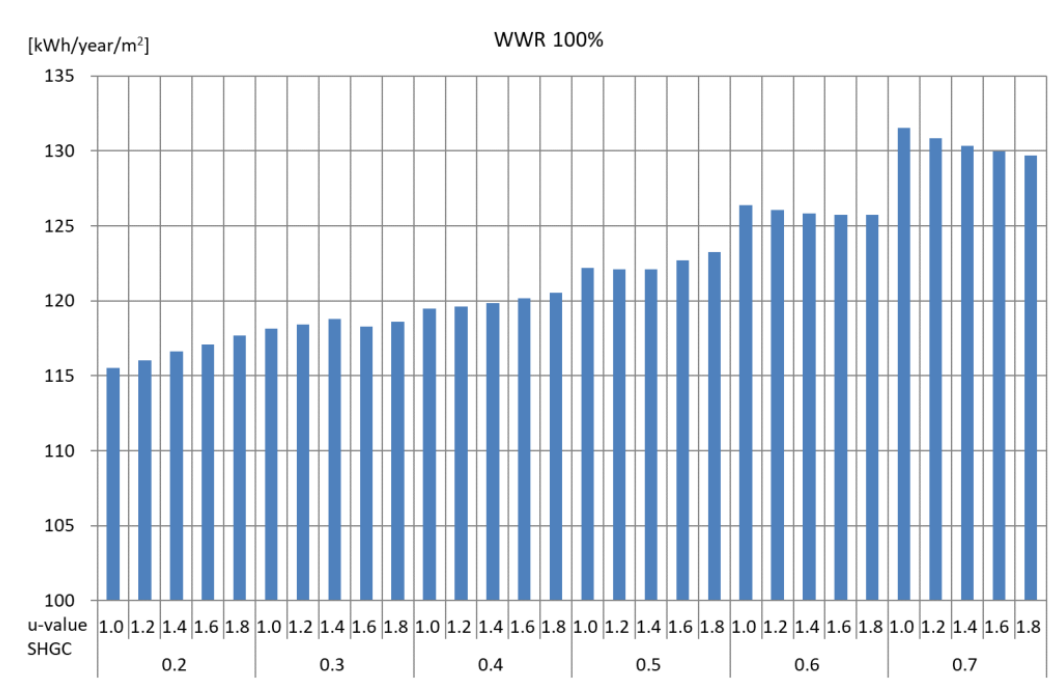
Figure 7. Energy demands/area when WWR = 100%